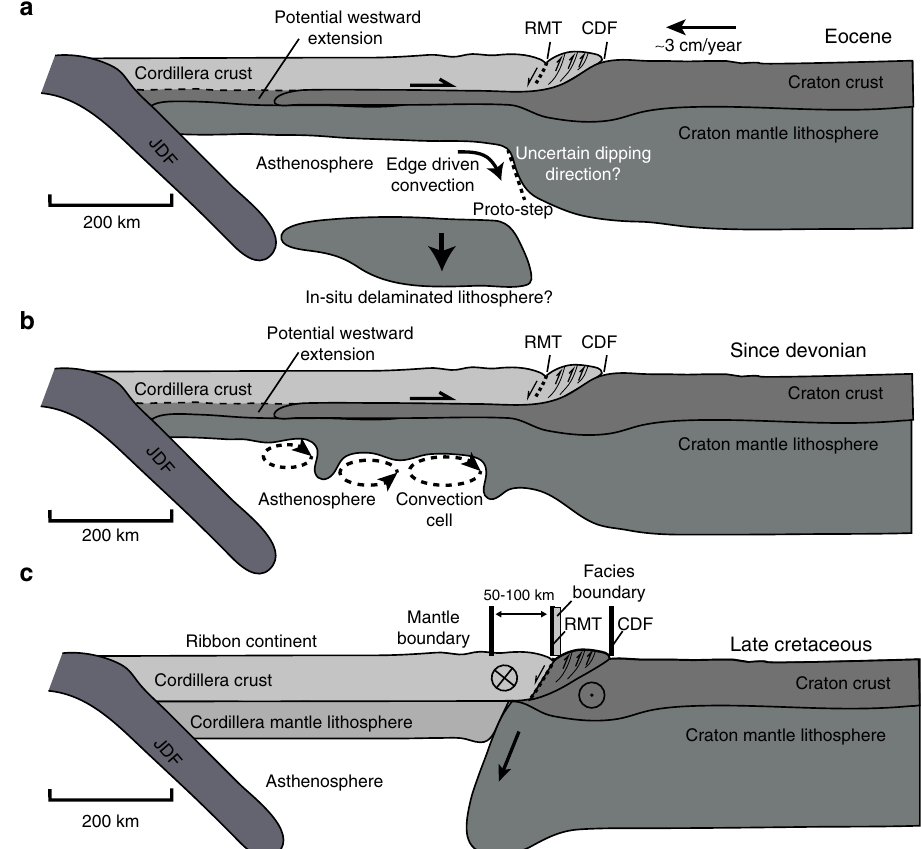
Fig. 5 Three mechanisms for the formation of the Cordillera – craton boundary. In the accretionary hypothesis, the Cordillera – craton boundary formed as a destructive boundary through either a lithosphere delamination 23 or b viscous thermal erosion. In the delamination model ( a ), the absolute North American plate motion rate is obtained from refs. 50 – 52 . c A continental collision model that involves terminal suturing between a ribbon continent and the North America